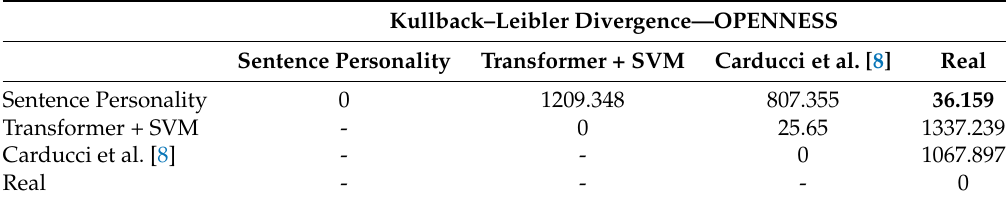
Table 4. Kullback–Leibler divergence computed among probability distributions on Openness.